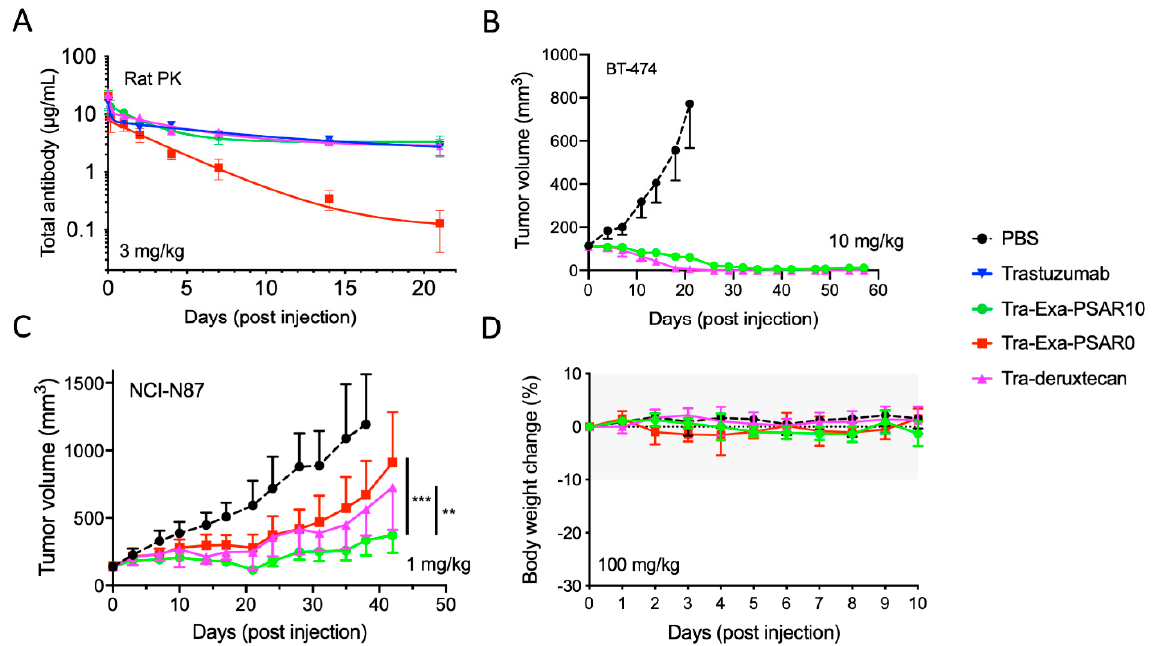
Figure 4. In vivo evaluation of Tra-Exa-PSAR10. ( A ) ADC pharmacokinetic study in Sprague-Dawley rats after a single intravenous ADC dose of 3 mg/kg. Total ADC concentration was assayed by anti-human IgG ELISA. ( B ) Antitumor activity in HER2+ SCID/BT-474 breast cancer model following a single intravenous ADC dose of 10 mg/kg. ( C ) Antitumor activity in HER2+ SCID/NCI-N87 gastric cancer model following a single sub-curative intravenous ADC dose of 1 mg/kg. ( D ) Mice tolerability experiment following a single intraperitoneal ADC dose of 100 mg/kg. (**: p < 0.01, ***: p <